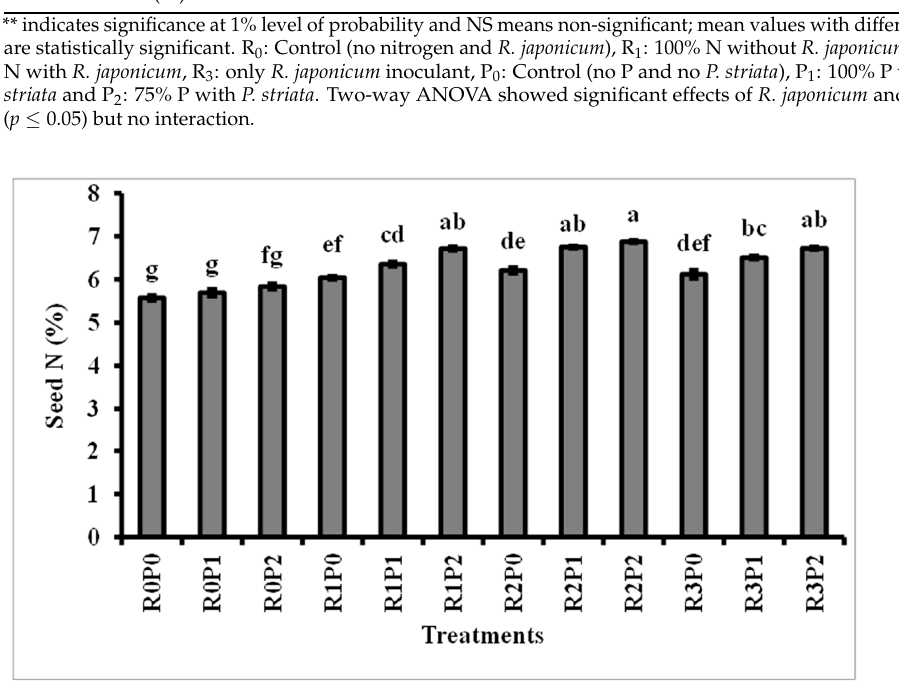
Figure 7. Interaction effect of Rhizobium japonicum and Pseudomonas striata on seed nitrogen content of soybean (mean ± SE, n = 3); R 0 : Control (no nitrogen and R. japonicum ), R 1 : 100% N